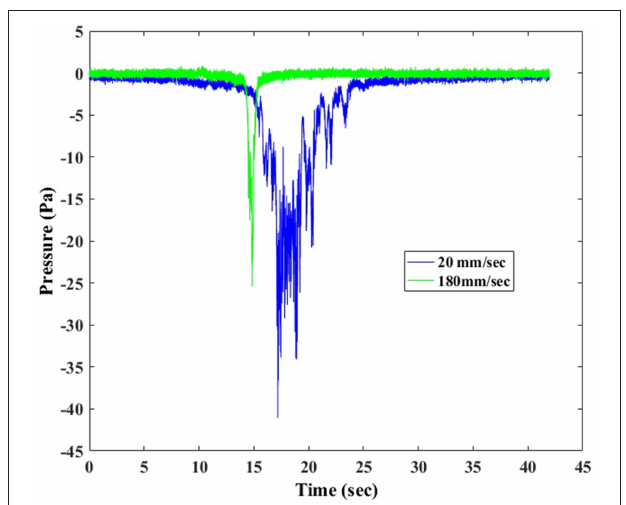
FIGURE 4 | Time history of pressures on roof pressure tap at different translating